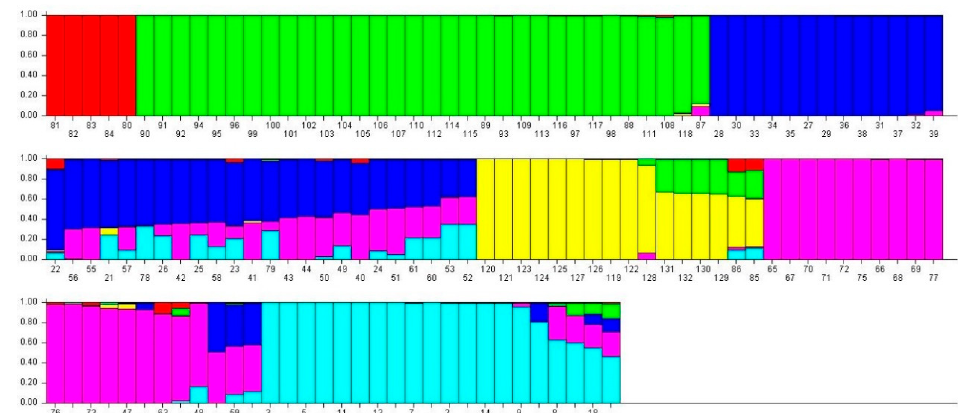
Figure 3. Q plot showing clustering of 132 accessions in 6 subpopulations based on an analysis of genotypic data using STRUCTURE software ver. 2.2. Each accession is indicated by vertical bars. The color subsections within each vertical bar represent the membership coefficient (Q) of the accession to different colors. Six groups were identified. The identified groups are I (red), II (lime), III (Blue), IV (yellow), V (Fuchsia), and VI (Aqua) colors in regular patterns.